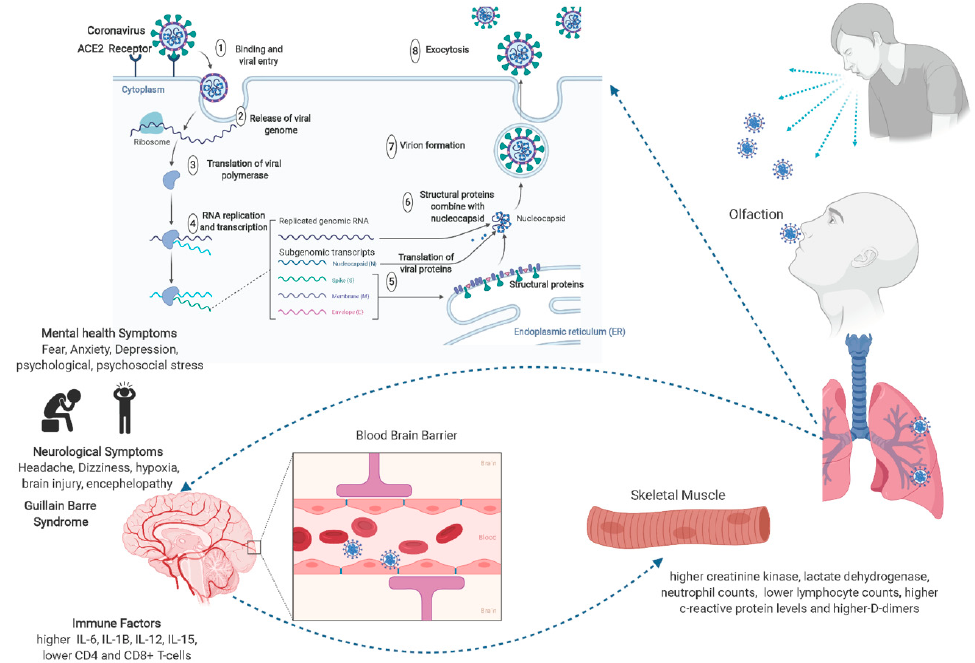
Figure 2. Putative mechanisms underlying neurobiological and psychological events of COVID-19 and their effect on mental health-related issues through psychoneuroimmunity. Virus–host interactions affect viral entry and replication—left panel: viral factor. SARS-CoV-2 is an enveloped positive single-stranded R.N.A. coronavirus. Two-thirds of viral R.N.A. is located in the first open reading frame that encodes 16 non-structure proteins. Host factors (right panel) can also influence susceptibility to infection and disease progression. COV2 enters the brain through olfaction, and since the virus is known to cross the blood–brain barrier, it can cause neurological symptoms like Guillain–Barré syndrome and mental health issues, including fear and anxiety for recovery. All these events are regulated by the cytokines and interleukins within the immune system.